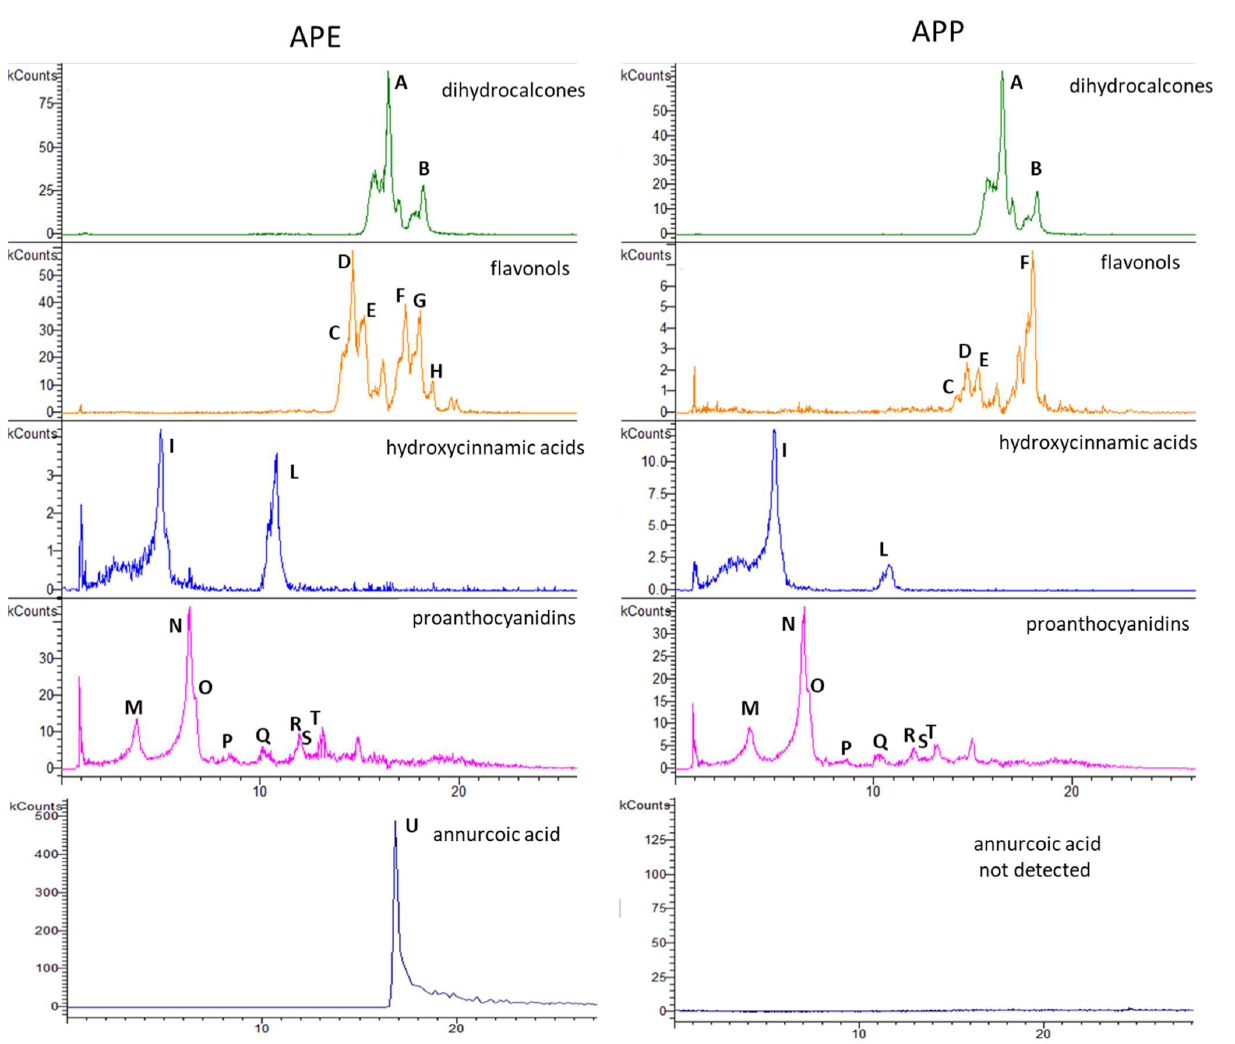
Figure 1. Exemplificative chromatograms of apple peel extract (APE) and apple pulp extract (APP) by LC-ESI-MSn. Dihydrochalcone and flavonol derivatives: 567 m / z phloretin-2-O-xylo-glucoside (A); 435 m / z phloretin-2-O-glucoside (B); 463 m / z quercetin-3-O-galactoside (C); 609 m / z rutin (D); 433 m/z quercetin-3-O-xyloside(E); 433 m / z quercetin-3-O-arabinoside (F); 447 m / z quercetin-3-O-rhamnoside (G); 477 m / z rhamnetin-3-O-glucoside (H); hydroxycinnamic acids: 535 m / z chlorogenic acid isomer 1 (I); 353.5 m / z chlorogenic acid isomer 2 (L). Proanthocyanidin derivatives: 289 m / z catechin (M); 577 m / z procyanidin dimer B isomer 1 (N); 577 m / z procyanidin dimer B isomer 2 (O); 1441 m / z procyanidin derivative (P); 865 m / z procyanidin trimer B (Q); 1441 m / z procyanidin pentamer B (R); 1153 m / z procyanidin tetramer B (S); 1729 m / z procyanidin derivative (T); 485 m / z annurcoic acid (U) by APCI ion sources. In the reported chromatograms, x axis was time (min) and y axis was